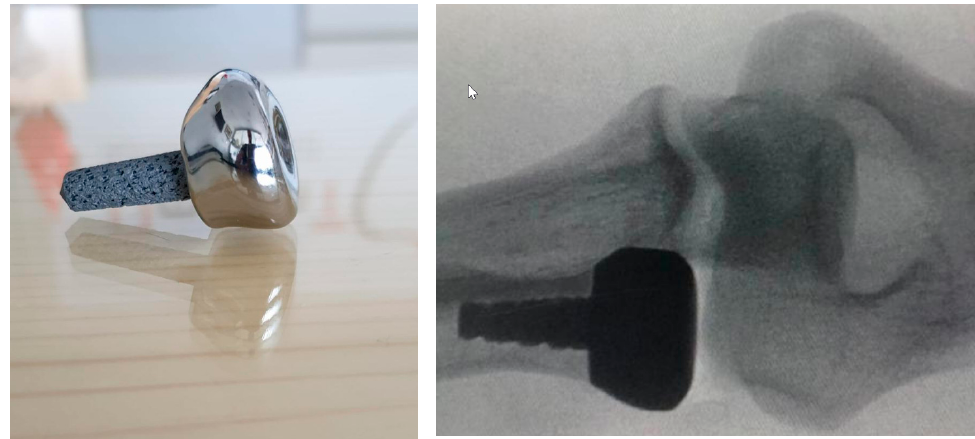
Figure 2. A 3D printed custom-made radial head prosthesis (left) and an x-ray of its implantation (right). Table 2 . Functional results and patient satisfaction of the four clinical cases.